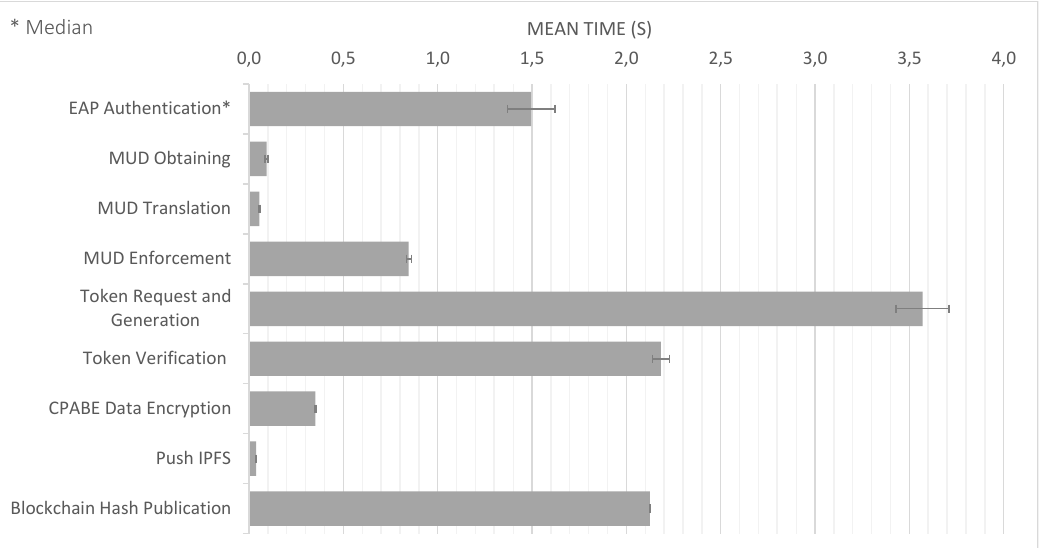
Figure 4. Time required for the different processes.